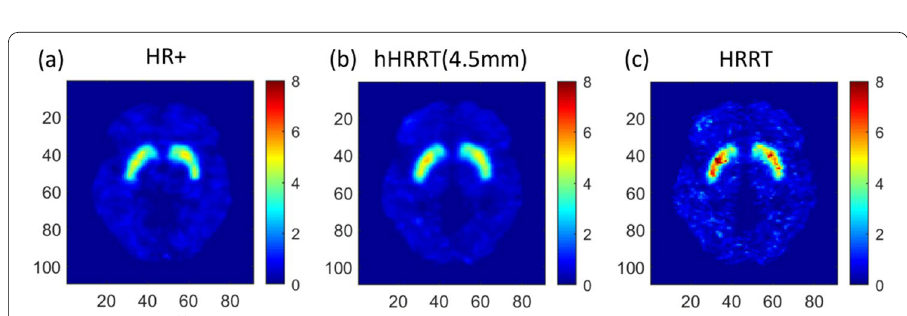
Experiment 2: Validation in human subjects